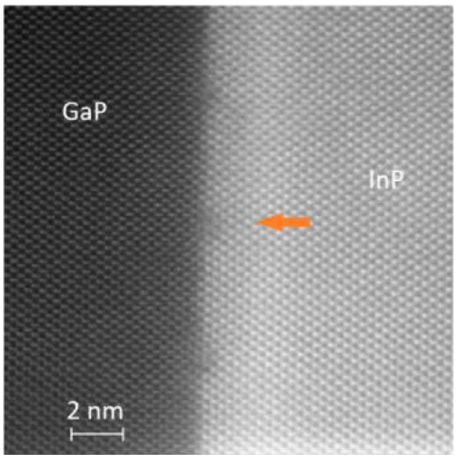
Fig. 6. HAADF-STEM image of the (0 0 1) NAsP template towards the (1 1 0) direction showing the GaP/InP